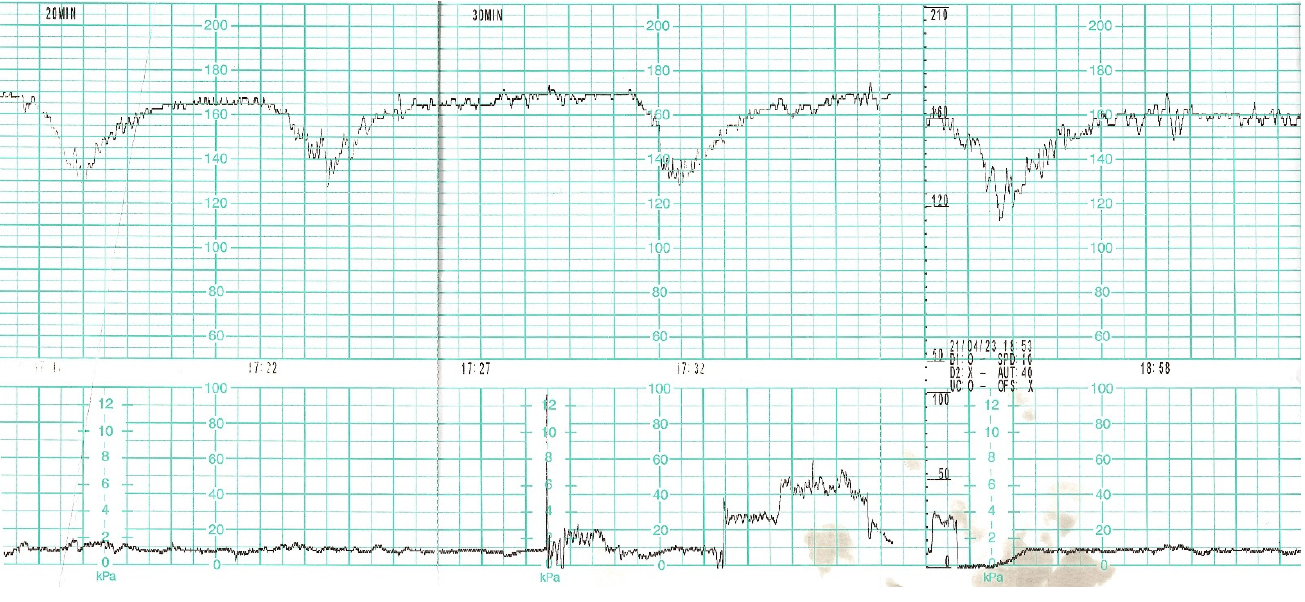
Figure 7. CTG record on day 2 of hospitalisation. Tachycardia, decelerations.